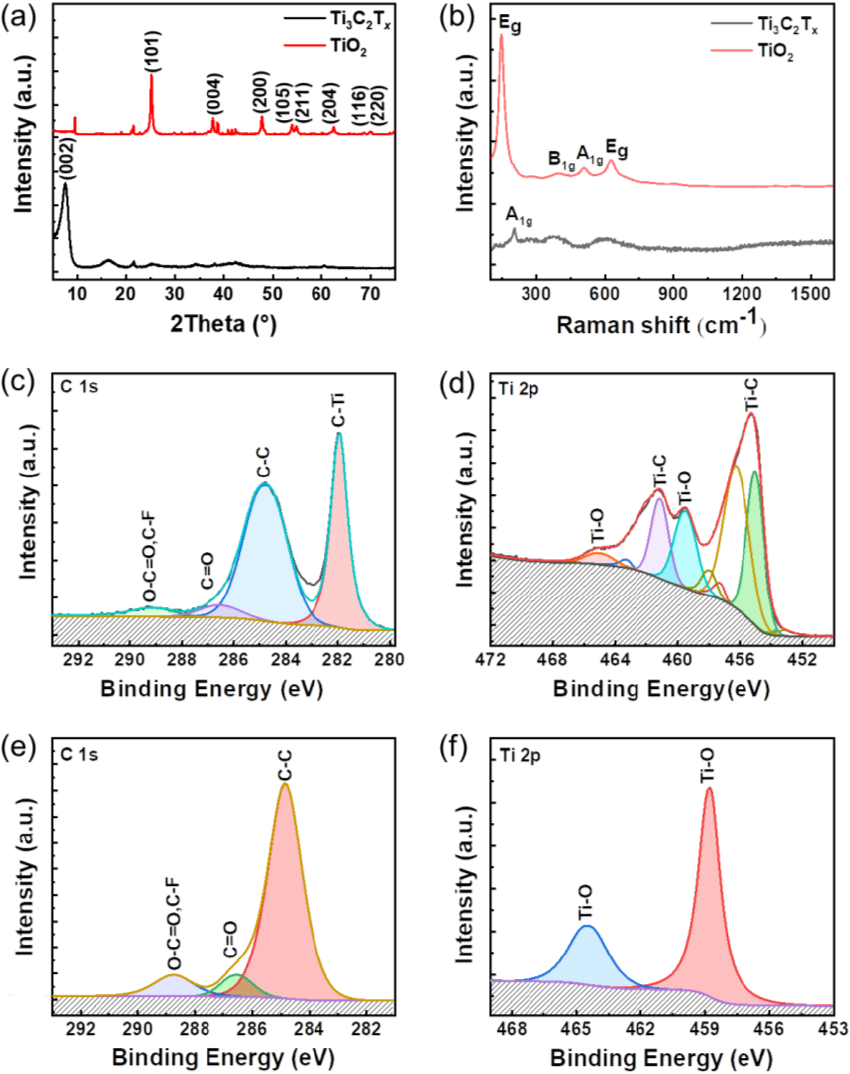
Figure 2. Characterization of Ti 3 C 2 T x nanosheets and TiO 2 nanoparticles. ( a ) XRD and ( b ) Raman spectra of Ti 3 C 2 T x nanosheets and TiO 2 nanoparticles. XPS spectra of ( c ) C 1s and ( d ) Ti 2p components of Ti 3 C 2 T x nanosheets. XPS spectra of ( e ) C 1s and ( f ) Ti 2p components of TiO 2 nanoparticles.